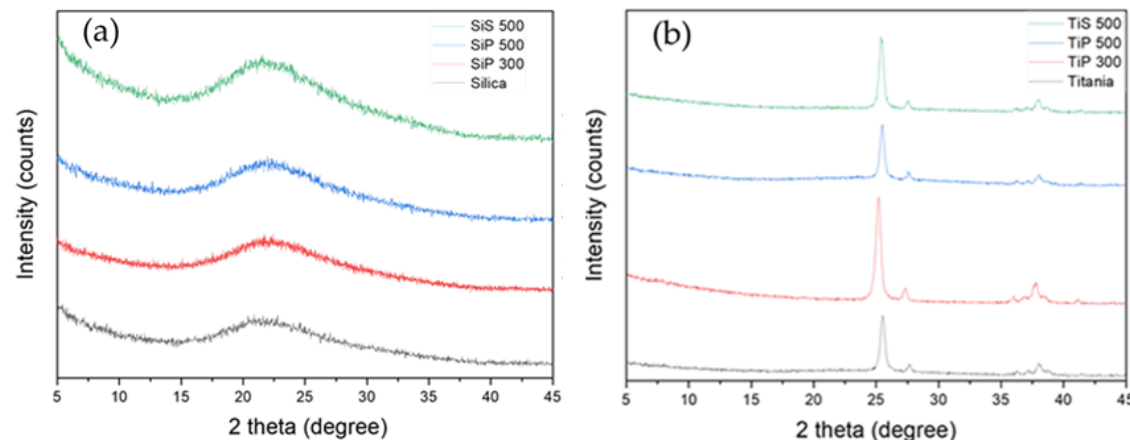
Figure 2. XRD patterns of ( a ) silica-based catalysts and ( b ) titania-based catalysts.